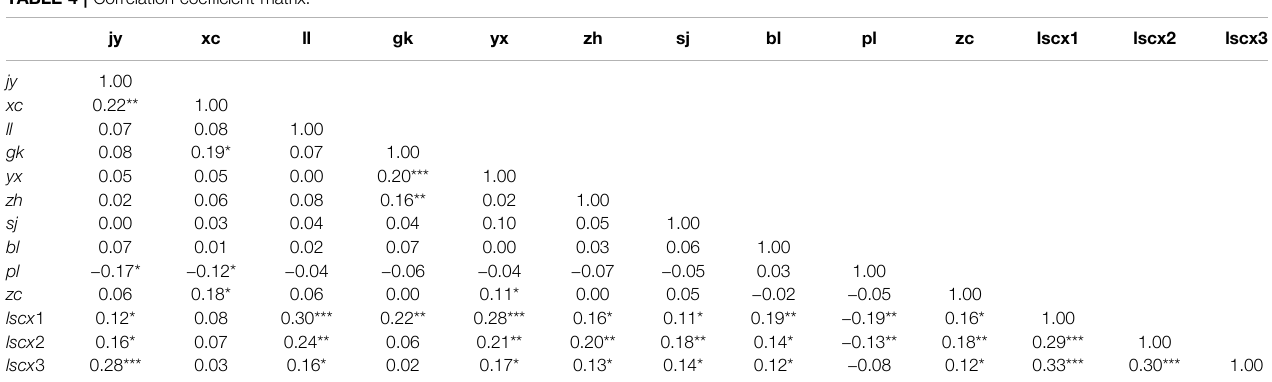
TABLE 4 | Correlation coef fi cient